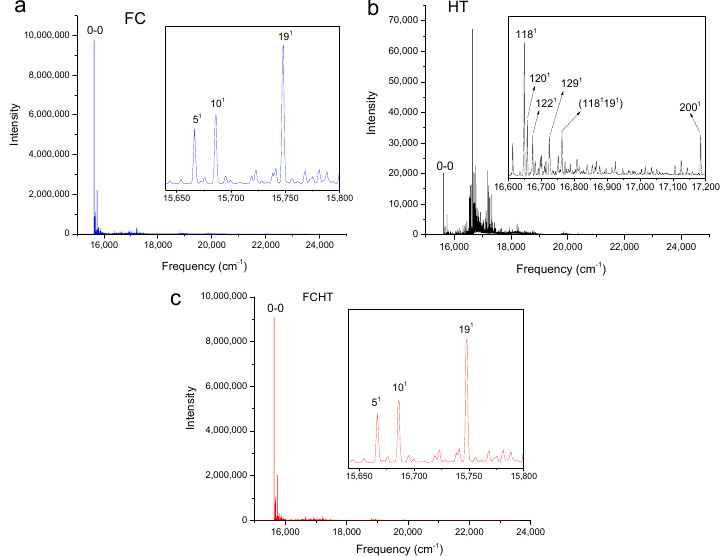
Figure 3. Calculated vibronic absorption spectra of chlorophyll f using the CAM-B3LYP functional and 6-31G(d) basis set, including the FC contribution ( a ), HT contribution ( b ), or both FCHT ( c ). The insets magnify specific regions of the spectra associated with assigned vibronic transitions.